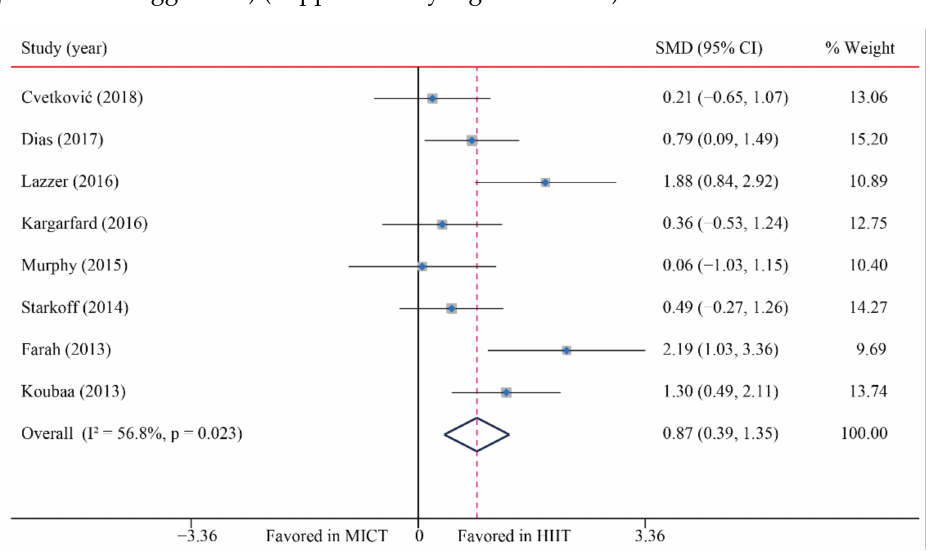
Figure 7. Effect of HIIT versus MICT on maximal oxygen